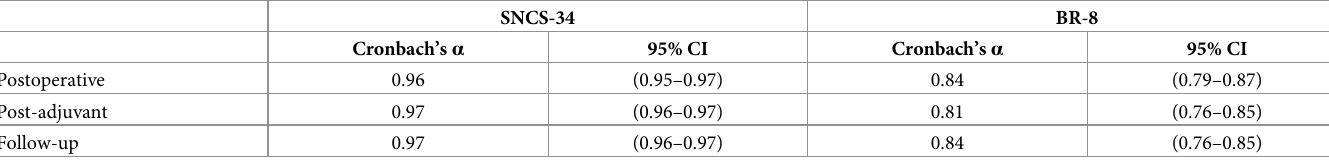
Table 2. Internal validation of SNCS-34 and BR8